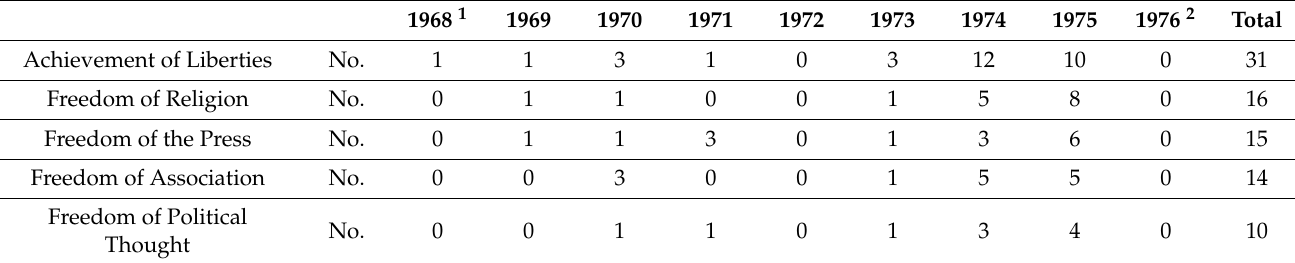
Table 1. Frequency data of